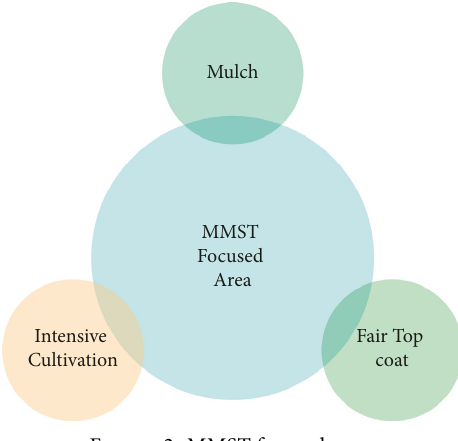
Figure 2: MMST focused